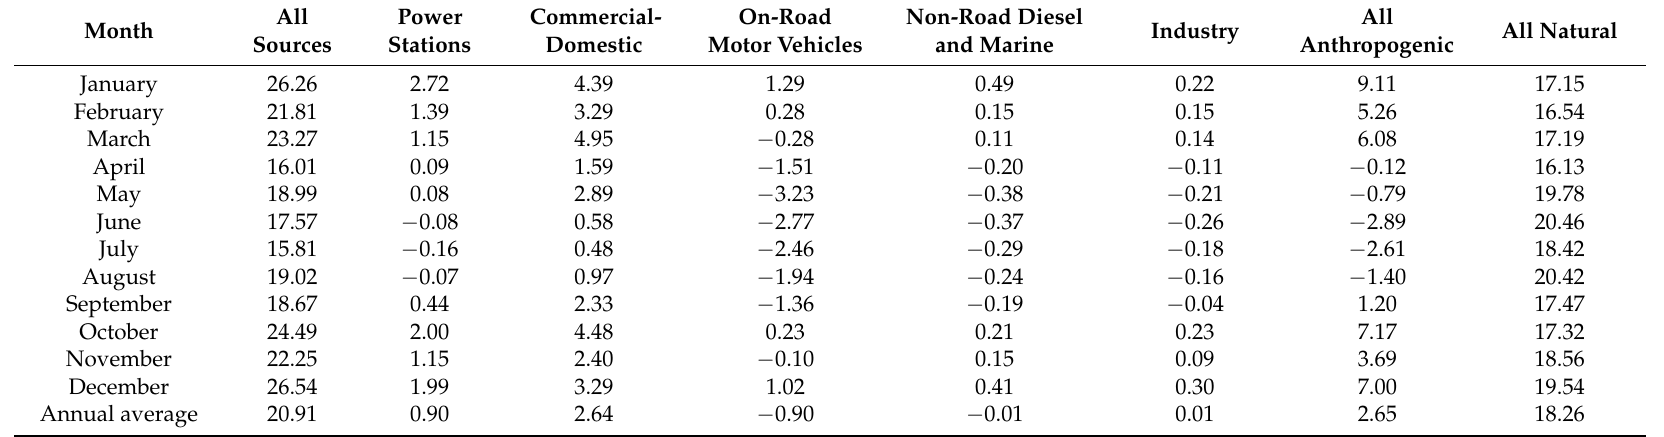
Table 4. Monthly average of daily maximum 1-h ozone concentration (ppb) in the Sydney northwest region for different months in 2008 under various emission